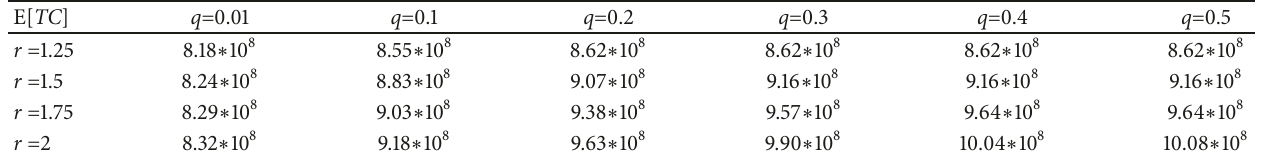
Table 3: The sensitivity of expected total cost to q (0.01, 0.5) and r (1.25, 2).